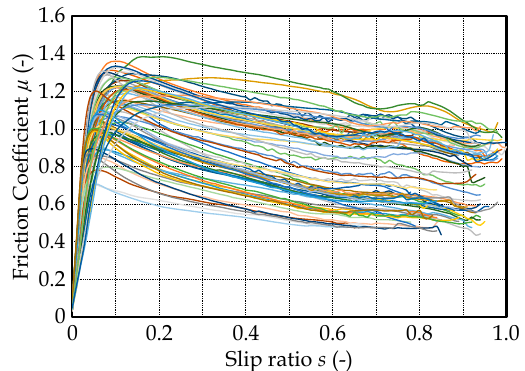
Figure 1. Characteristics of the road friction coefficient [19]. The 74 lines represent 74 tire data. The 74 lines are color coded to uniquely identify the friction coefficient change of each tire with slip ratio change. Since the types of colors that can be used are limited, same colors are assigned to multiple tire data as long as it is not confusing.